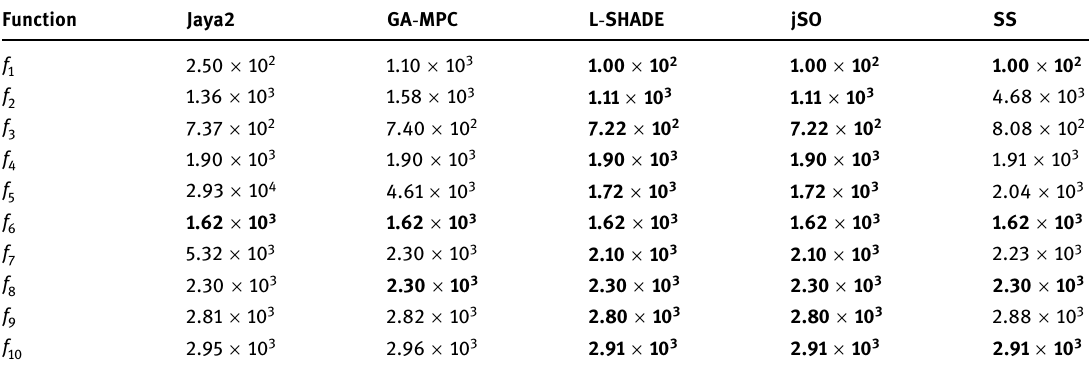
Table A5: The CEC 2020 ( = D 20 ) median function values achieved by Jaya2, GA - MPC, L - SHADE, jSO, and SS over 30 runs and 200,000 function evaluations